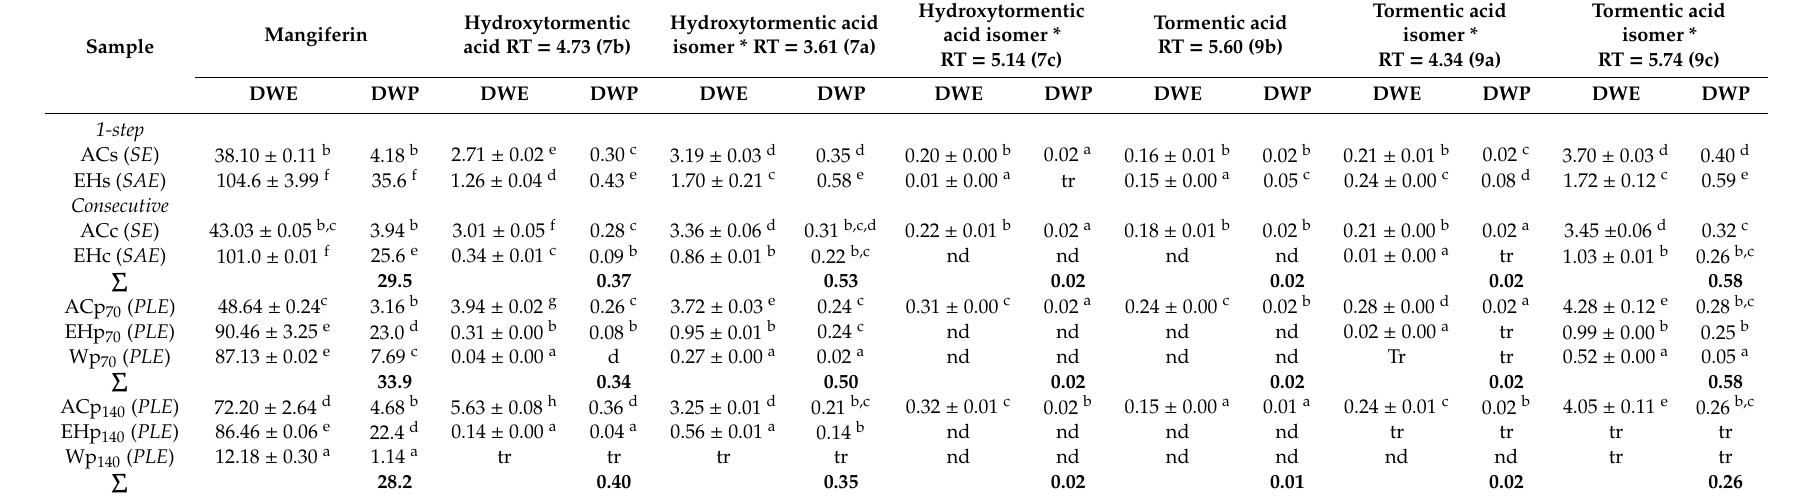
Table 4. Quantification of secondary metabolites present in the extracts of A. theiformis mg / g DWE or mg / g DWP.